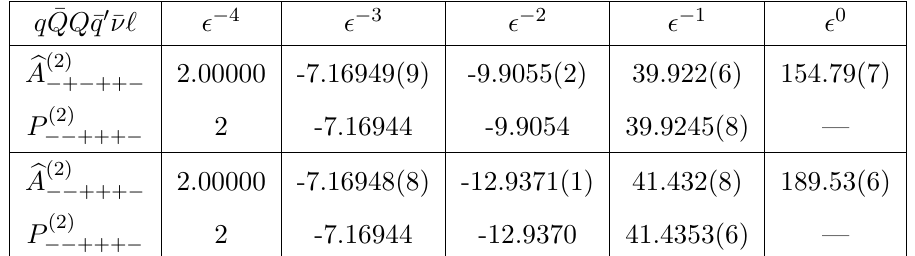
Table 6 . The numerical comparison of ^ A (2) (2) de(cid:12)ned in eq. (3.6), using kinematic point of eq. (5.1), in the HV P